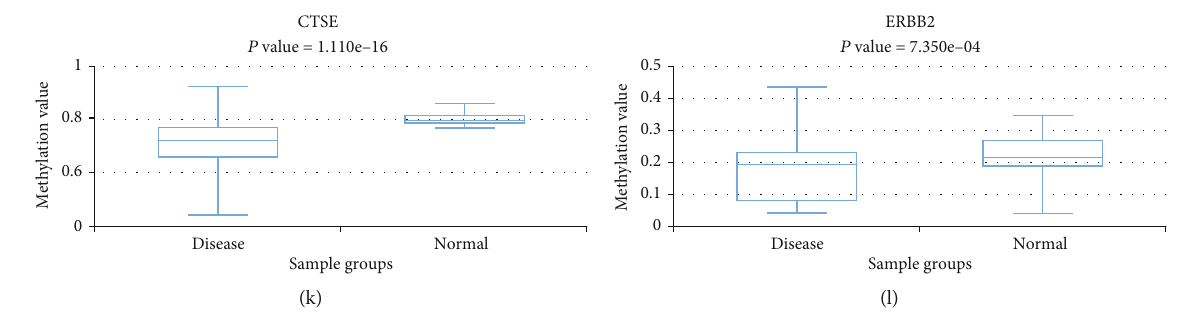
Figure 11: Methylation analyses of 12 overlapped DEGs. The methylation levels of (a) CDK1, (b) PLD1, (c) MET, (d) F2RL1, (e) XDH, (f) NEK2, (g) TOP2A, (h) NQO1, (i) CCND1, (j) PTK6, (k) CTSE, and (l) ERBB2 PDAC and corresponding normal tissues were explored using DiseaseMeth 2.0.